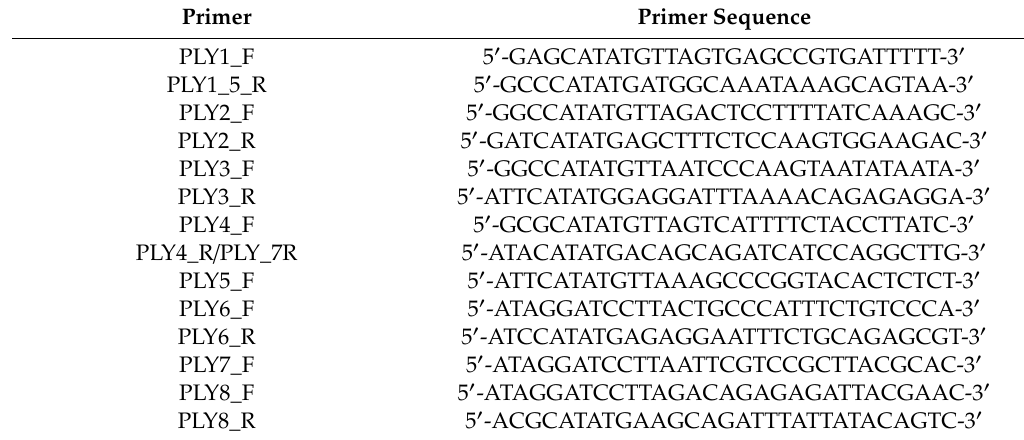
Table 2. The primers used to amplify the truncated PLY fragments. Primer Primer